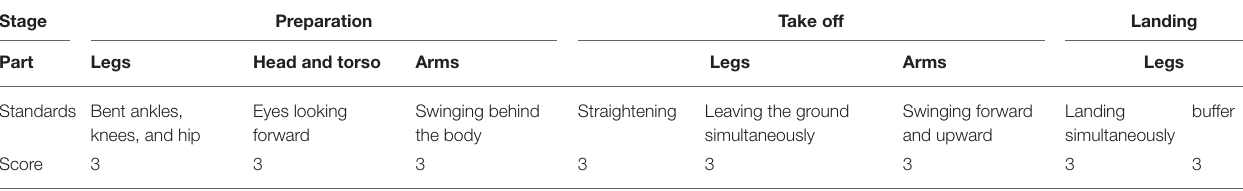
TABLE 1 | Assessment scale of the jump test. Stage Preparation Take off Landing Part Legs Head and torso Arms Legs Arms Legs Standards Bent ankles, Eyes looking Swinging behind Straightening Leaving the ground Swinging forward Landing buffer knees, and hip forward the body simultaneously and upward simultaneously